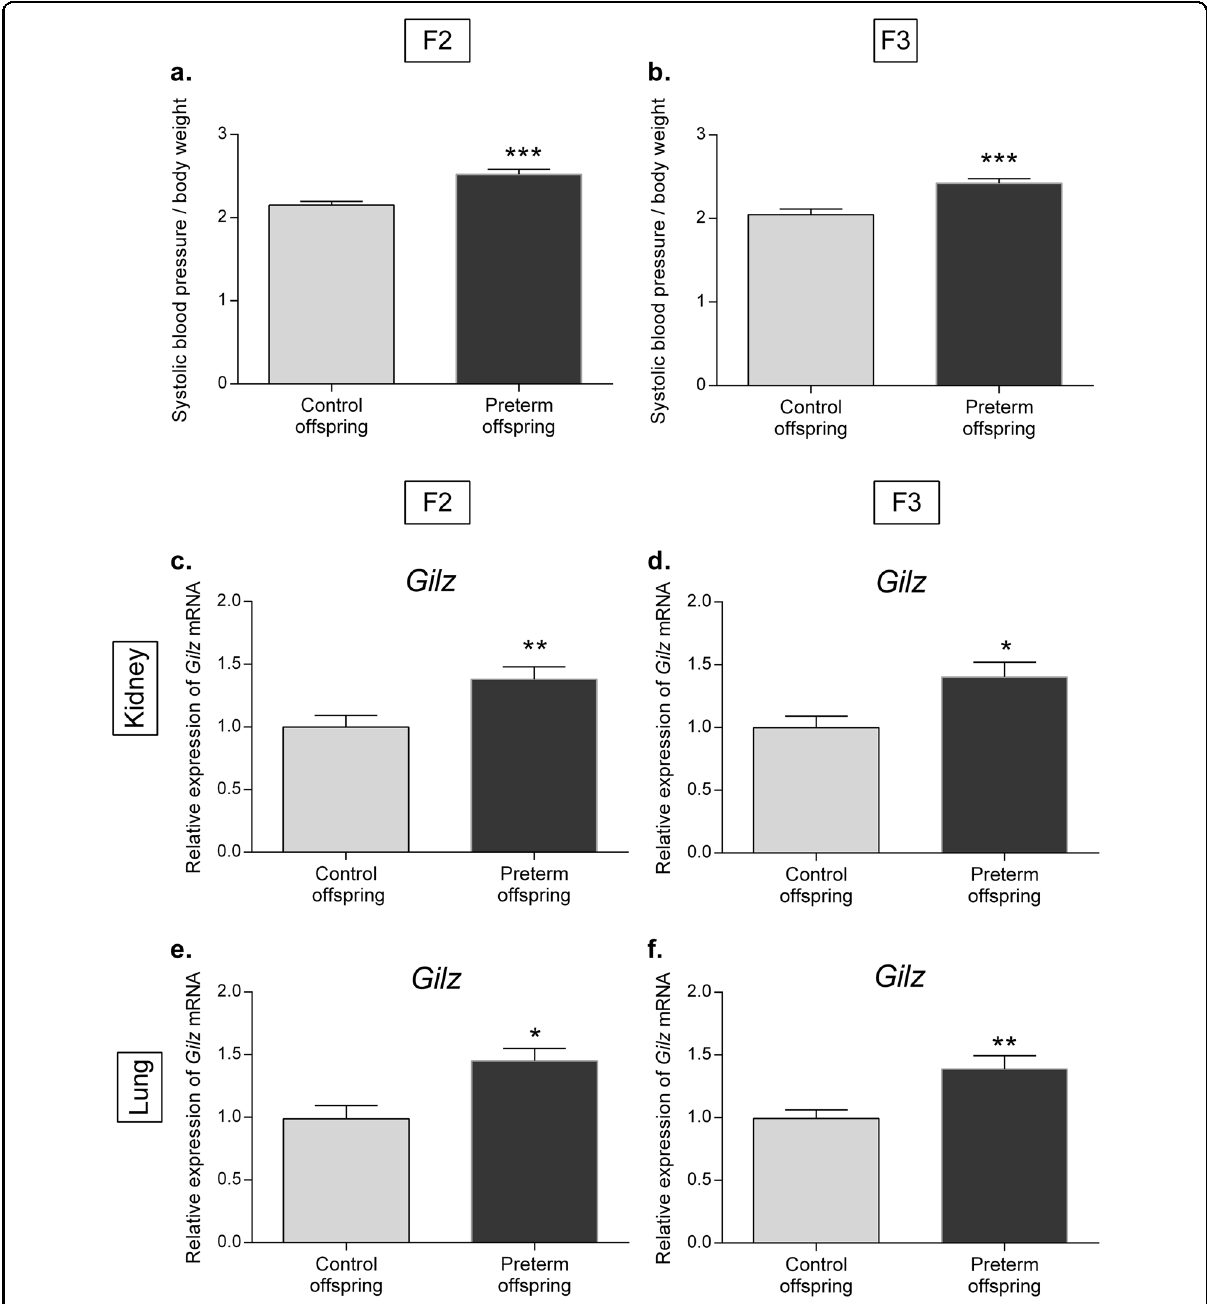
Fig. 6 Characteristics of the offspring of premature or control male mice at 6 months of age (M6) in the second (F2) and the third (F3) generations. Systolic blood pressure to body weight ratio in former premature and control M6 male offspring in the F2 ( a ) and F3 ( b ) generations. Relative renal mRNA expression of Gilz in preterm and control male offspring in the F2 ( c ) and F3 ( d ) generations. Relative pulmonary mRNA expression of Gilz in the F2 ( e ) and F3 ( f ) generations. Relative mRNA expression in mice was determined using reverse transcription-quantitative PCR (RT-qPCR). The results are expressed as the ratio of attomoles of speci fi c genes relative to the geometric mean of three housekeeping genes ( 36B4 , beta-actin and HPRT1 ), normalized to the expression of control mice, arbitrarily set at 1. n = 6 mice in each group. * P < 0.05, ** P < 0.01, *** P < 0.001. Nonparametric Mann – Whitney U-